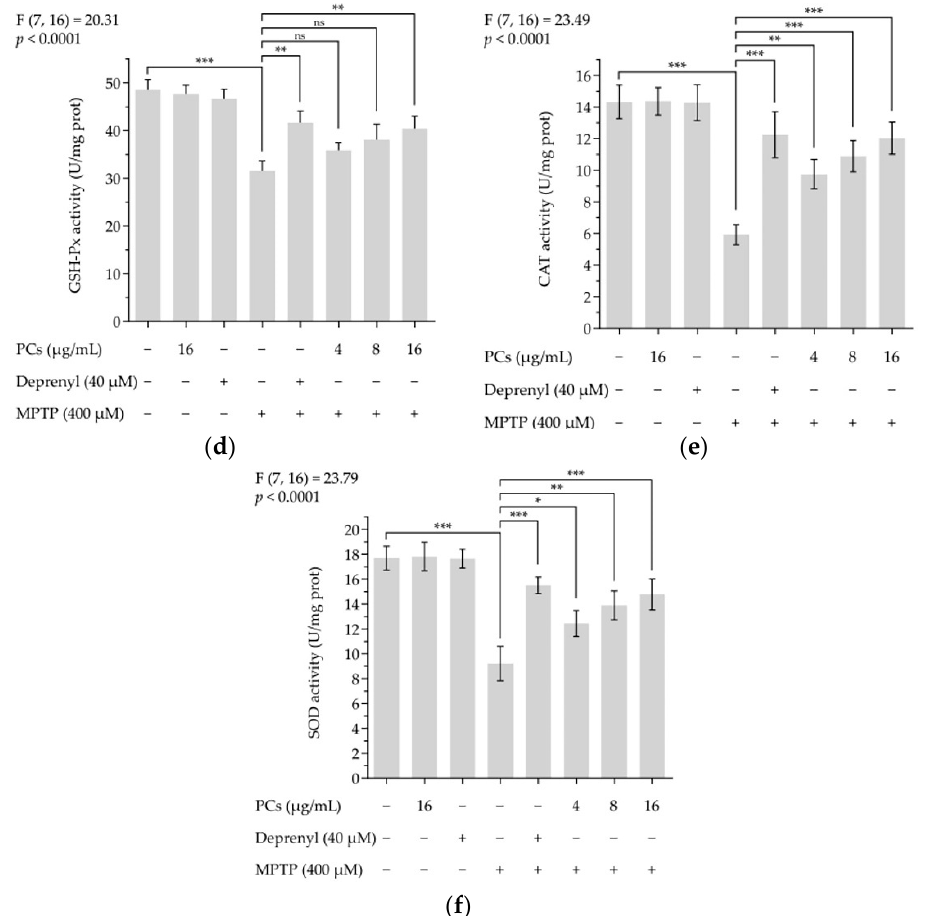
Figure 7. Effects of PCs on oxidative stress of zebrafish larvae treated with MPTP. ( a ) ROS levels were measured by fluorescent microscopy and imaging analysis; ( b ) ROS levels were measured via image J software; ( c ) MDA levels; ( d ) GSH-Px activity; ( e ) CAT activity; ( f ) SOD activity. F and p values of the one-way analysis of variance are presented above each chart. The results of Tukey’s post hoc test are presented for selected comparisons: ns, p > 0.05; *, p < 0.05; **, p < 0.01; ***, p < 0.001; the error bars are SD.